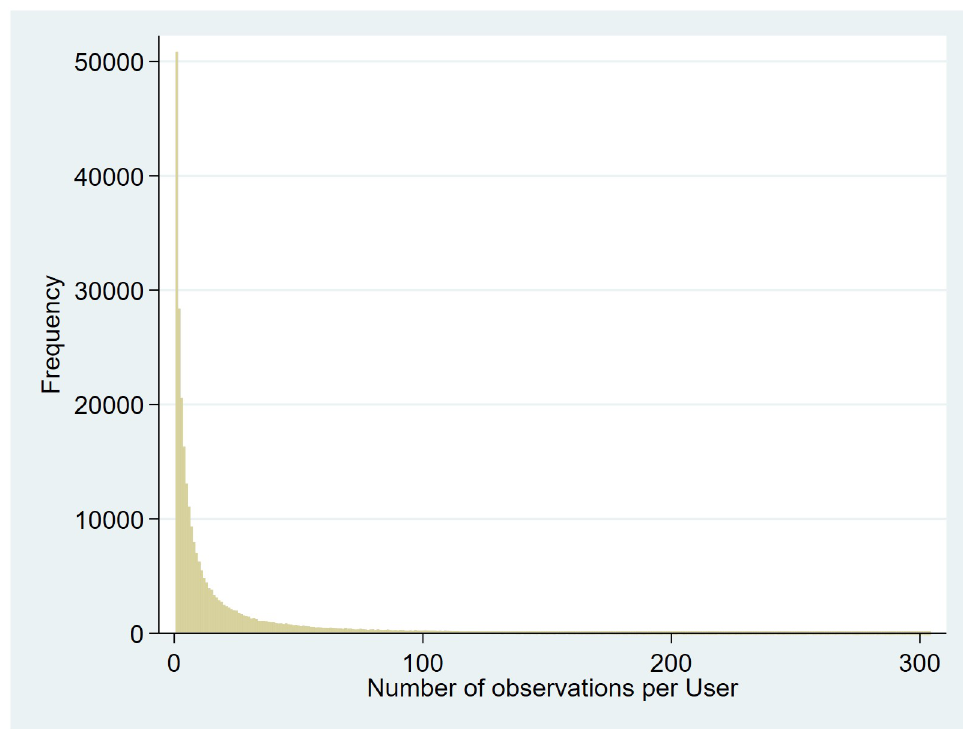
Fig 4. Distribution of number of observations per